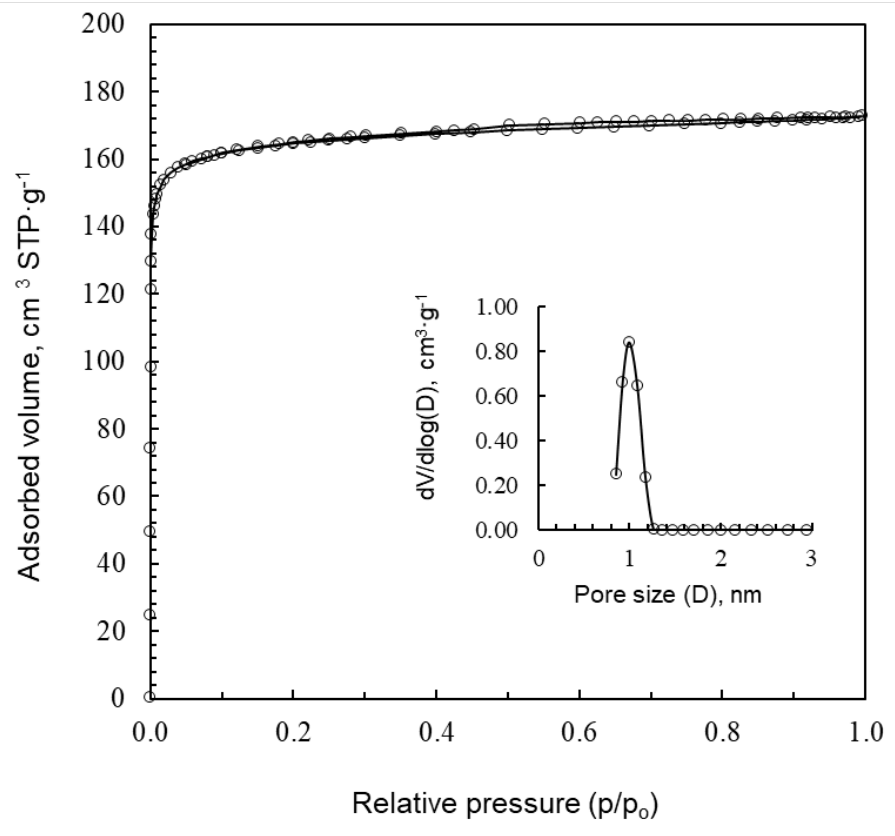
Figure 11. N 2 adsorption isotherms of SF(Ag). Inset plot: pore size distribution of SF(Ag).